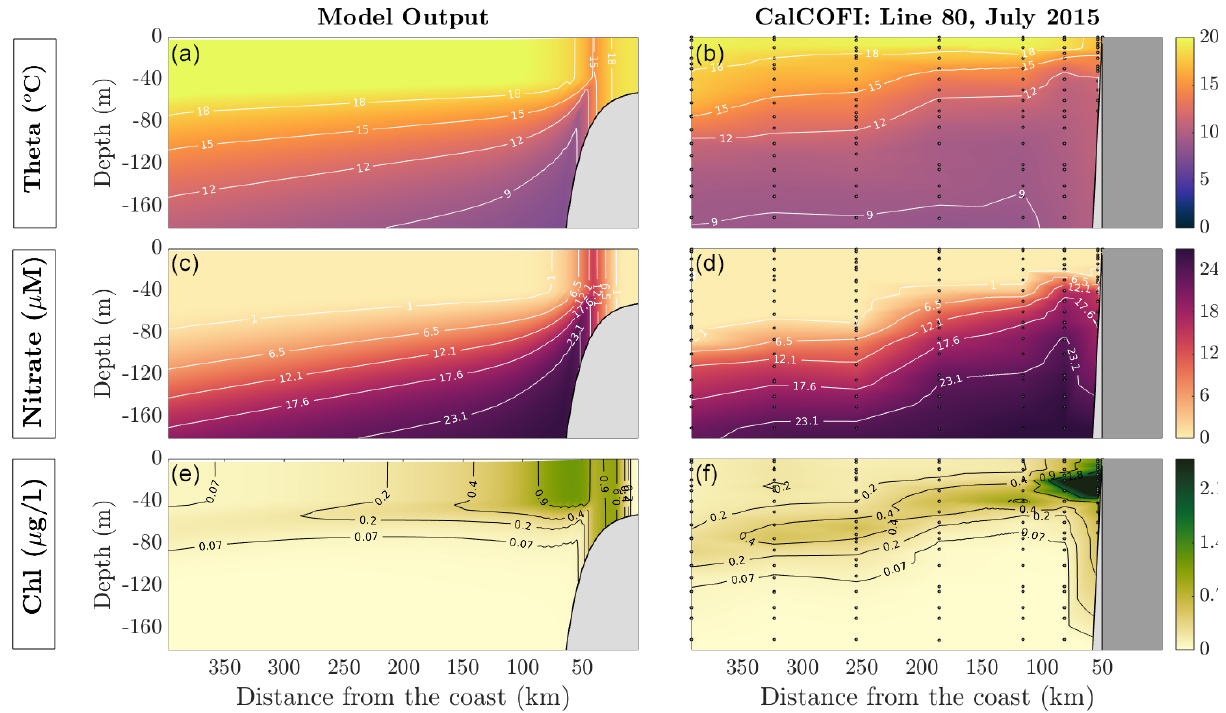
Figure 7. Model validation against in situ CalCOFI data taken along line 80 (point conception) during July 2015. The column on the left shows output from the model under constant wind forcing and is averaged over the last 5 model years. The column on the right shows values taken from CalCOFI and interpolated onto a σ coordinate grid to allow for direct comparison. The dots in the panels are locations where the data are sampled. This figure shows the comparison between potential temperature, θ (a, b) , nitrate (c, d) , and chlorophyll concentration (e, f)